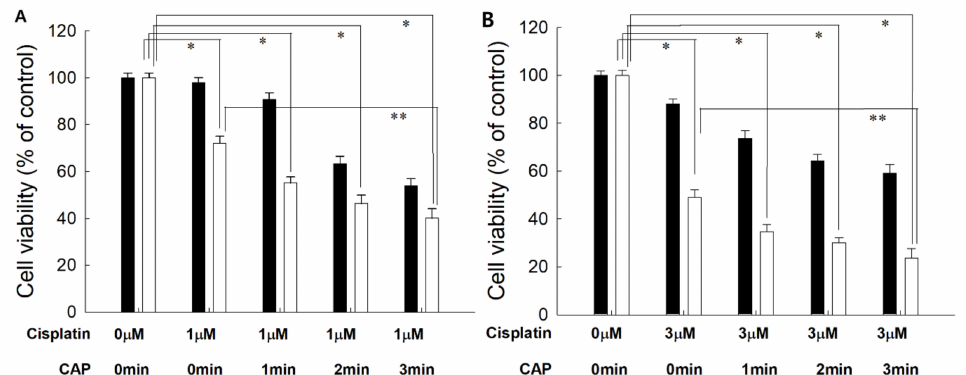
Figure 4. The e ff ect of CAP exposure time on the cell viability of HGF-1 ( (cid:4) ) and SCC-15 ( (cid:3) ). ( A ) Cisplatin, 1 µ M; ( B ) cisplatin, 3 µ M. Cisplatin at a dose of 1.0 µ M or 3.0 µ M was exposed to cells for 6 h, and then media was replaced with fresh media. These were then irradiated with CAP for various periods of time. *, **: p <